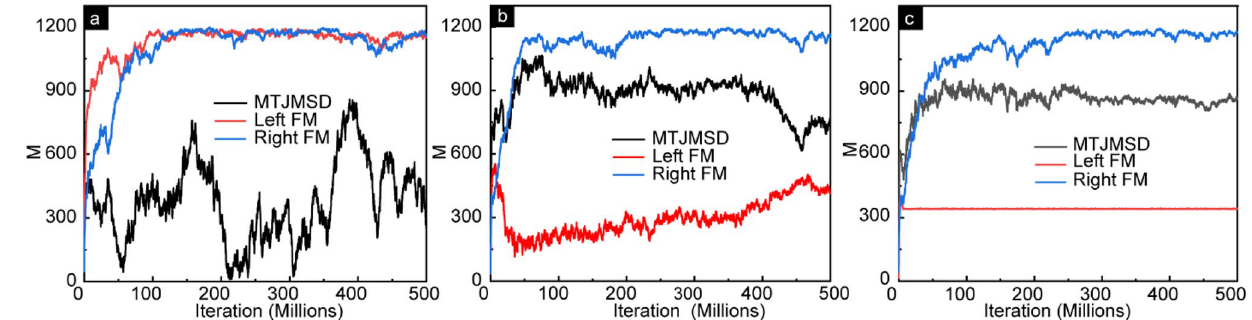
Figure 2. Magnetic moment vs. iteration counts showing temporal evolution of the MTJMSD, left FM, and right FM for the cases of ( a ) AL Y = 0, ( b ) AL Y = 0.1, and ( c ) AL Y = 1. In all the cases kT = 0.1. J mL = − 1 and J mR = 1, S = 1for molecules and FM electrodes. MTJMSD started from random state and stabilized over 500 M